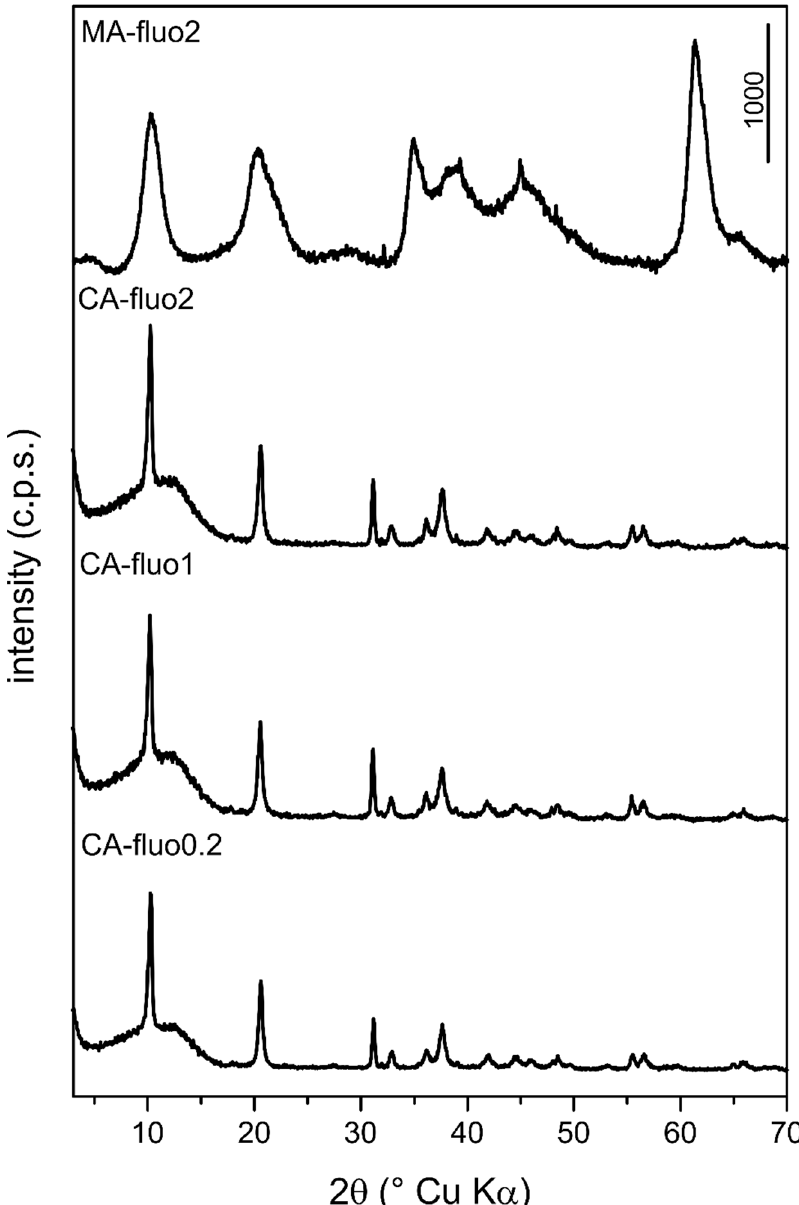
Figure 1. Powder X-Ray diffraction patterns of the fluorescein samples. Figure 1. Powder X-ray di ff raction patterns of the fluorescein